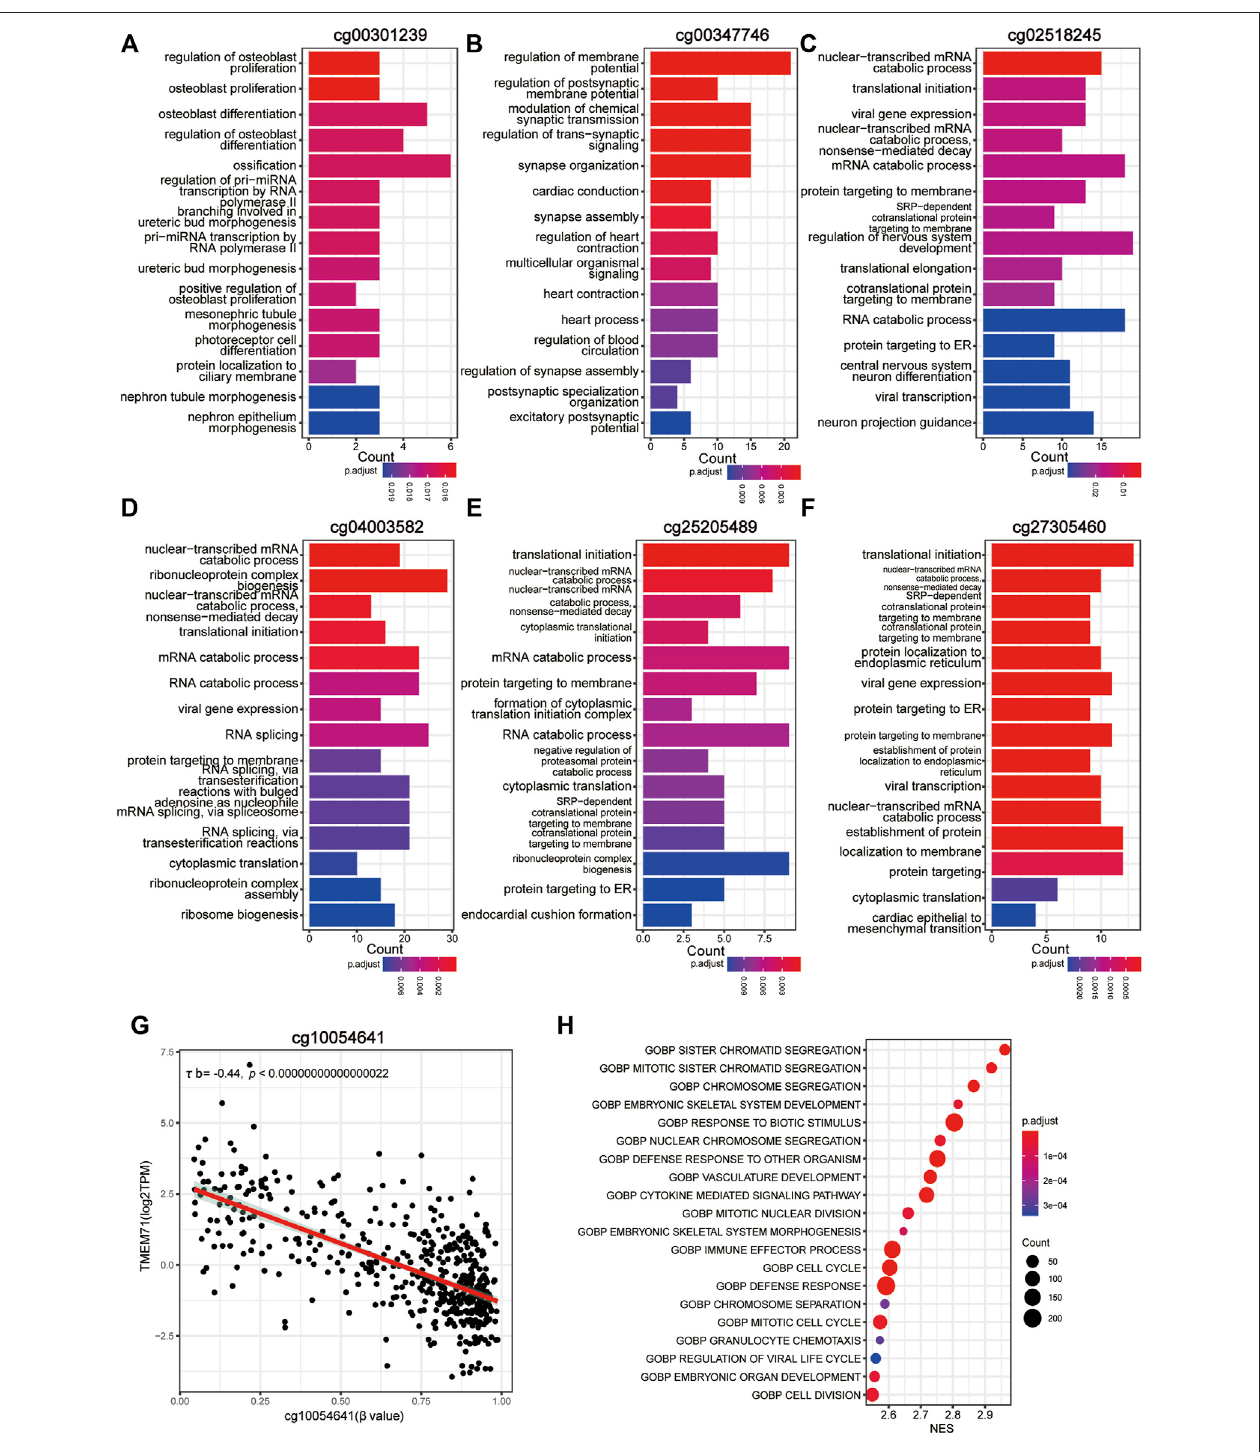
FIGURE 7 | Functional characterization of the CpG signature. (A – F) Bar plot of GO annotation for genes with a strong correlation with non-promoter signature CpGs. (G) Correlation between methylation of cg10054641 and TMEM71 expression. (H) Dotplot of the GSEA results of the CpG signature.